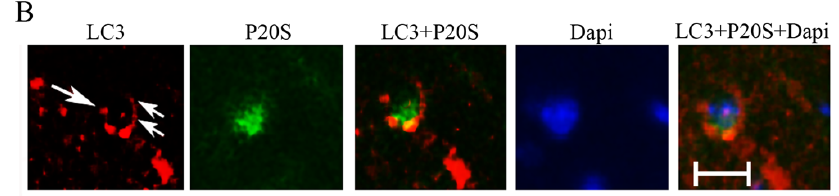
Figure 6. Representative immunofluorescence for LC3, P20S and Dapi. Pictures ( A ) report LC3-, and P20S-immunofluorescence along with Dapi-histofluorescence and their co-localization within area penumbra of a mouse following MCA (Ischemia) and the homologous region from a sham-operated mouse (Sham). It is evident the loss of LC3 + 20S co-localization, which occurs in area penumbra (ischemia) compared with control (Sham). ( B ) Representative images of cytosolic LC3 puncta occurring within neurons from area penumbra . White arrows indicate the merge between LC3 and P20S. Scale bar ( A ) = 100 µ m; Scale bar (insert, A ) = 10 µ m. Scale bar ( B ) = 10 µ m.